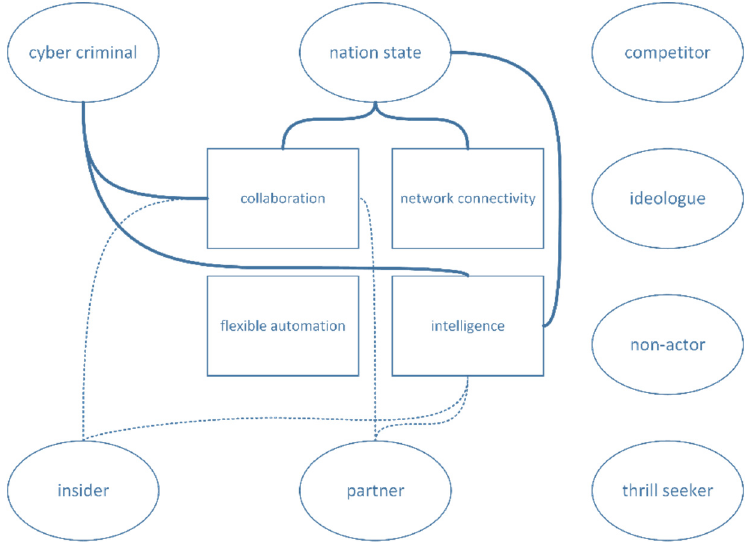
Figure 4. How the threat actors and features of a FoF are connected. Direct threats are marked with solid lines and threat vector access with dashed lines. solid lines and threat vector access with dashed